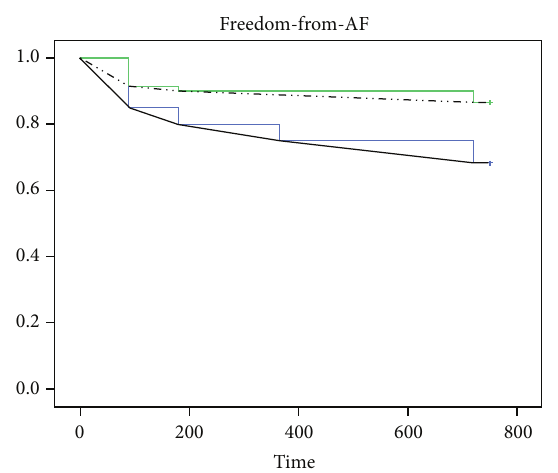
Figure 2: The Kaplan-Meier survival analysis shows a signifi- cant difference in freedom-from-AF recurrence between patients undergoing atrial fibrillation ablation using the first-generation Cryoballoon (CB1) and the second-generation Cryoballoon (CB2) catheter (Log Rank 𝑝 = 0.017